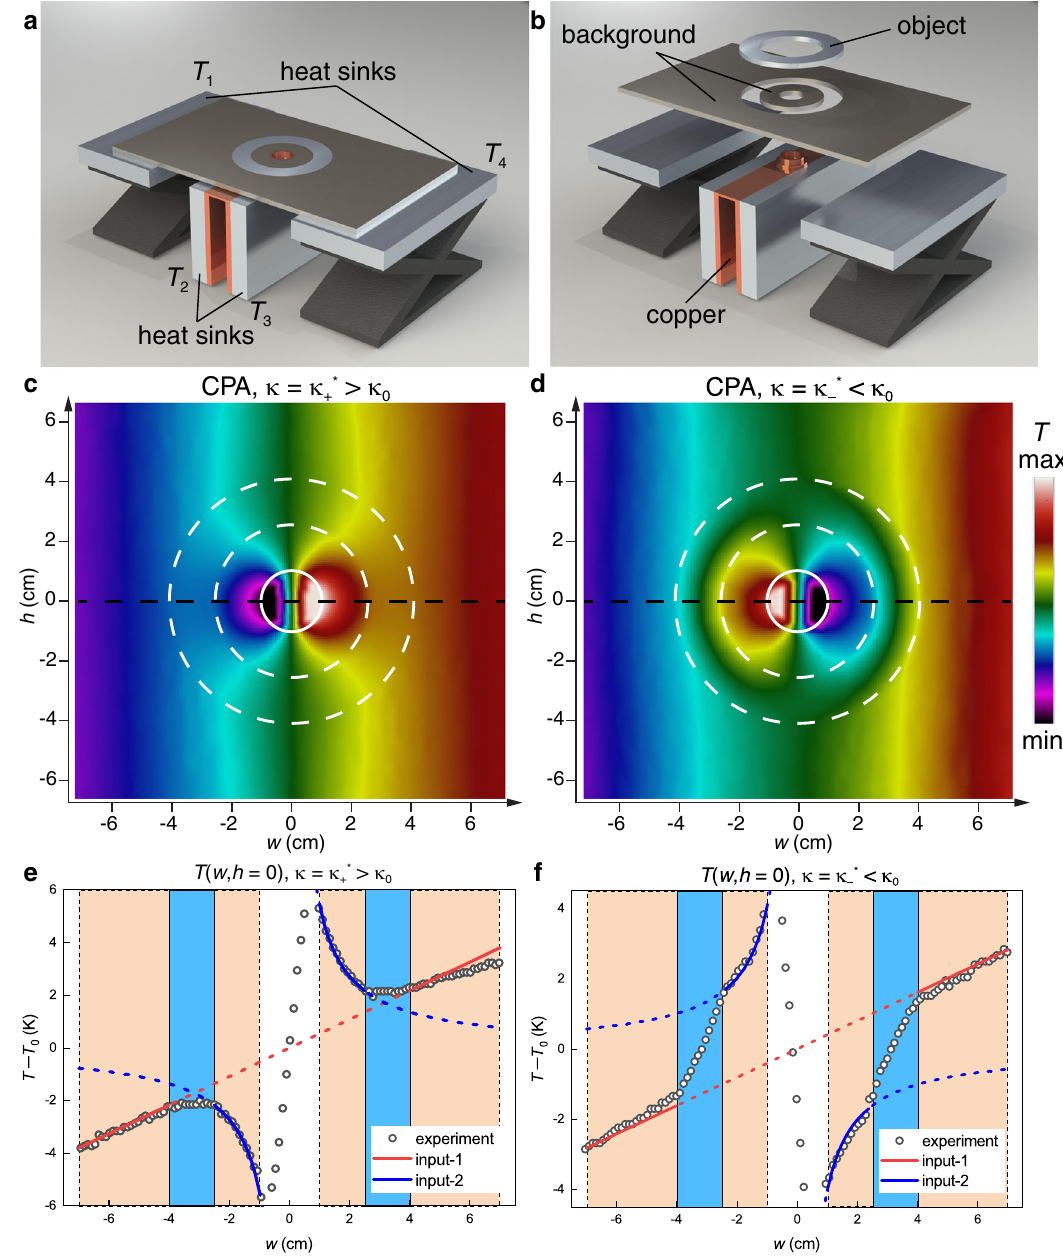
Fig. 4 Experimental demonstration of thermal coherent perfect absorption (CPA). a , b Schematics of the assembled( a ) and disassembled ( b ) experimental setup. c , d Measured temperature pro fi les of the system when the thermal conductivity of the object (indicated with white dashed lines) κ is ( c ) larger and ( d ) smaller than that of the background κ 0 . e , f Measured temperature distributions along the line h = 0 (black dashed lines in c and d ). The regions of the background (beige) and the object (light blue) are shaded. The incident fi elds input-1 (red) and input-2 (blue) are also